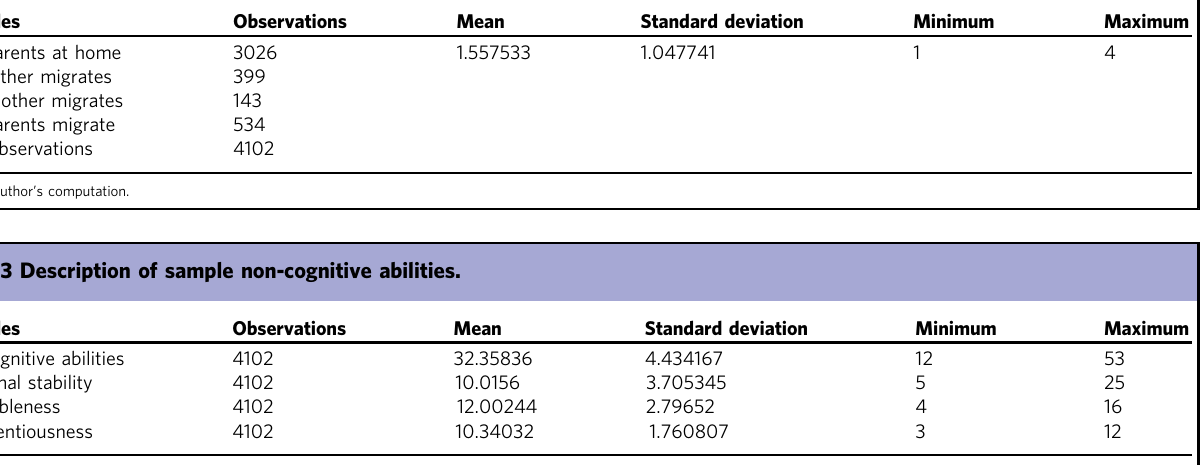
Table 2 Description of sample parental migration. Variables